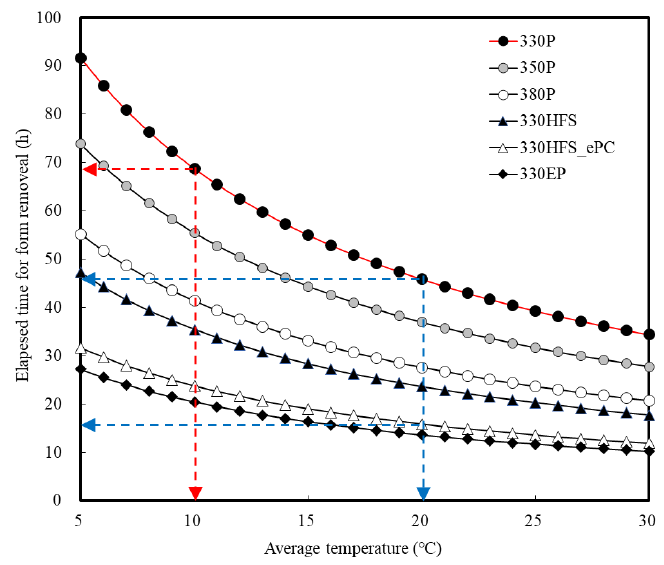
Figure 13. Variation in the elapsed time at strength of 5 MPa for concrete.